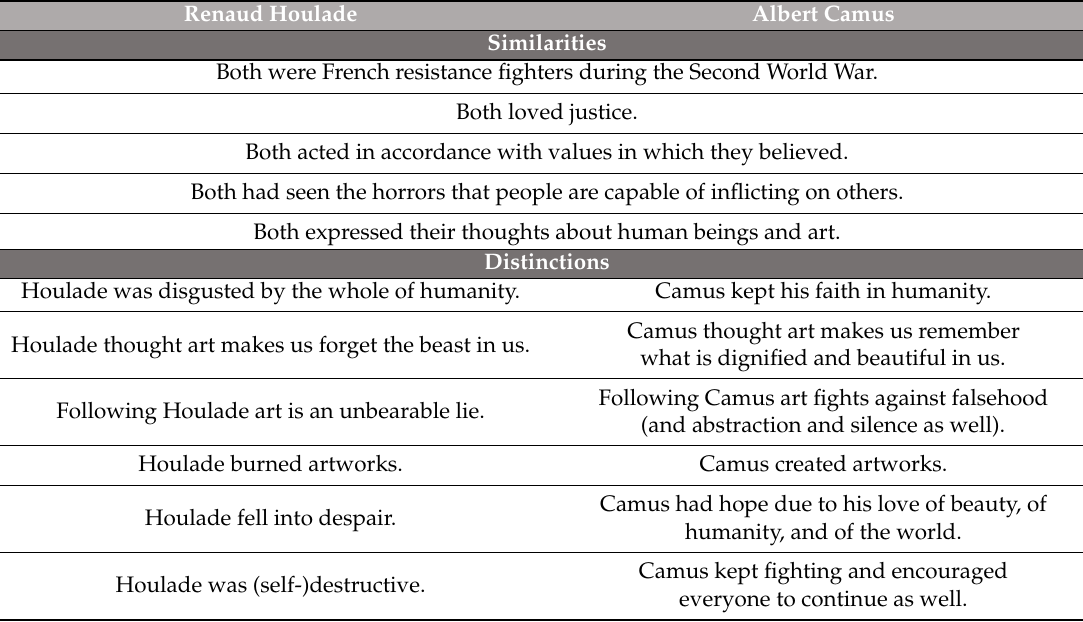
Table 1. Similarities and distinctions between Renaud Houlade and Albert